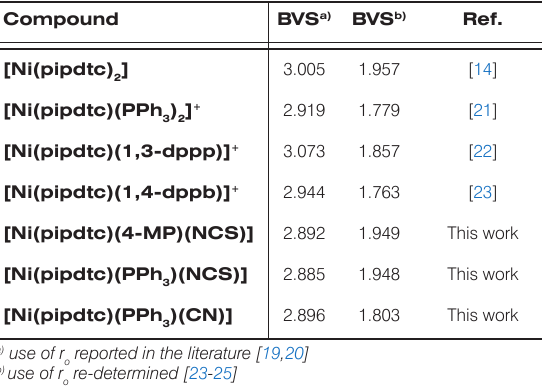
Table 5. Bond Valence Sums (BVS) for divalent nickel complexes.